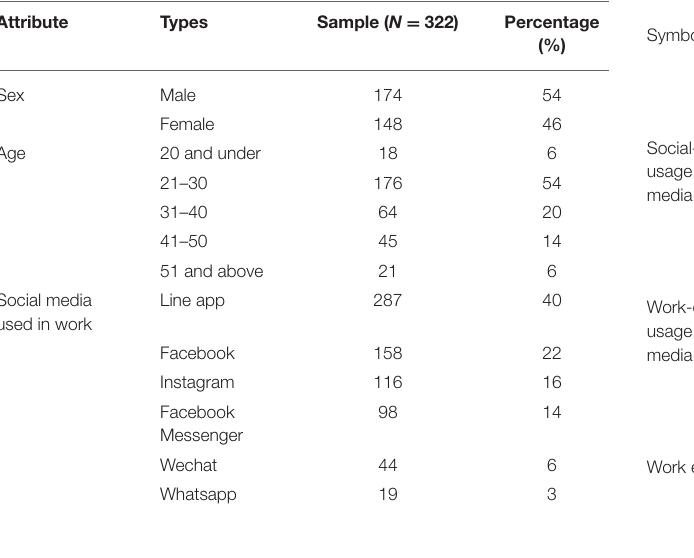
TABLE 1 | Sample demographic.